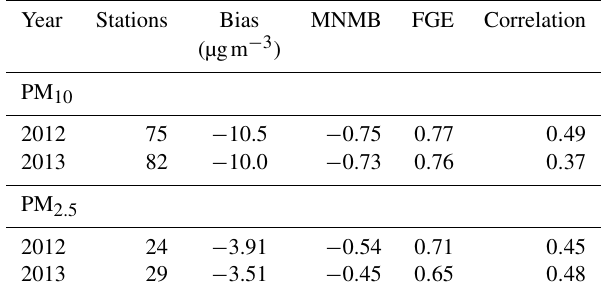
Table 7. Statistics of the comparison between the MOCAGE sim- ulation and the AQeR database measurements, corresponding to classes 1 to 5 from the classification of Joly and Peuch (2012) for the different seasons included in the years 2012 and 2013. The table presents results for PM 10 and PM 2 . 5